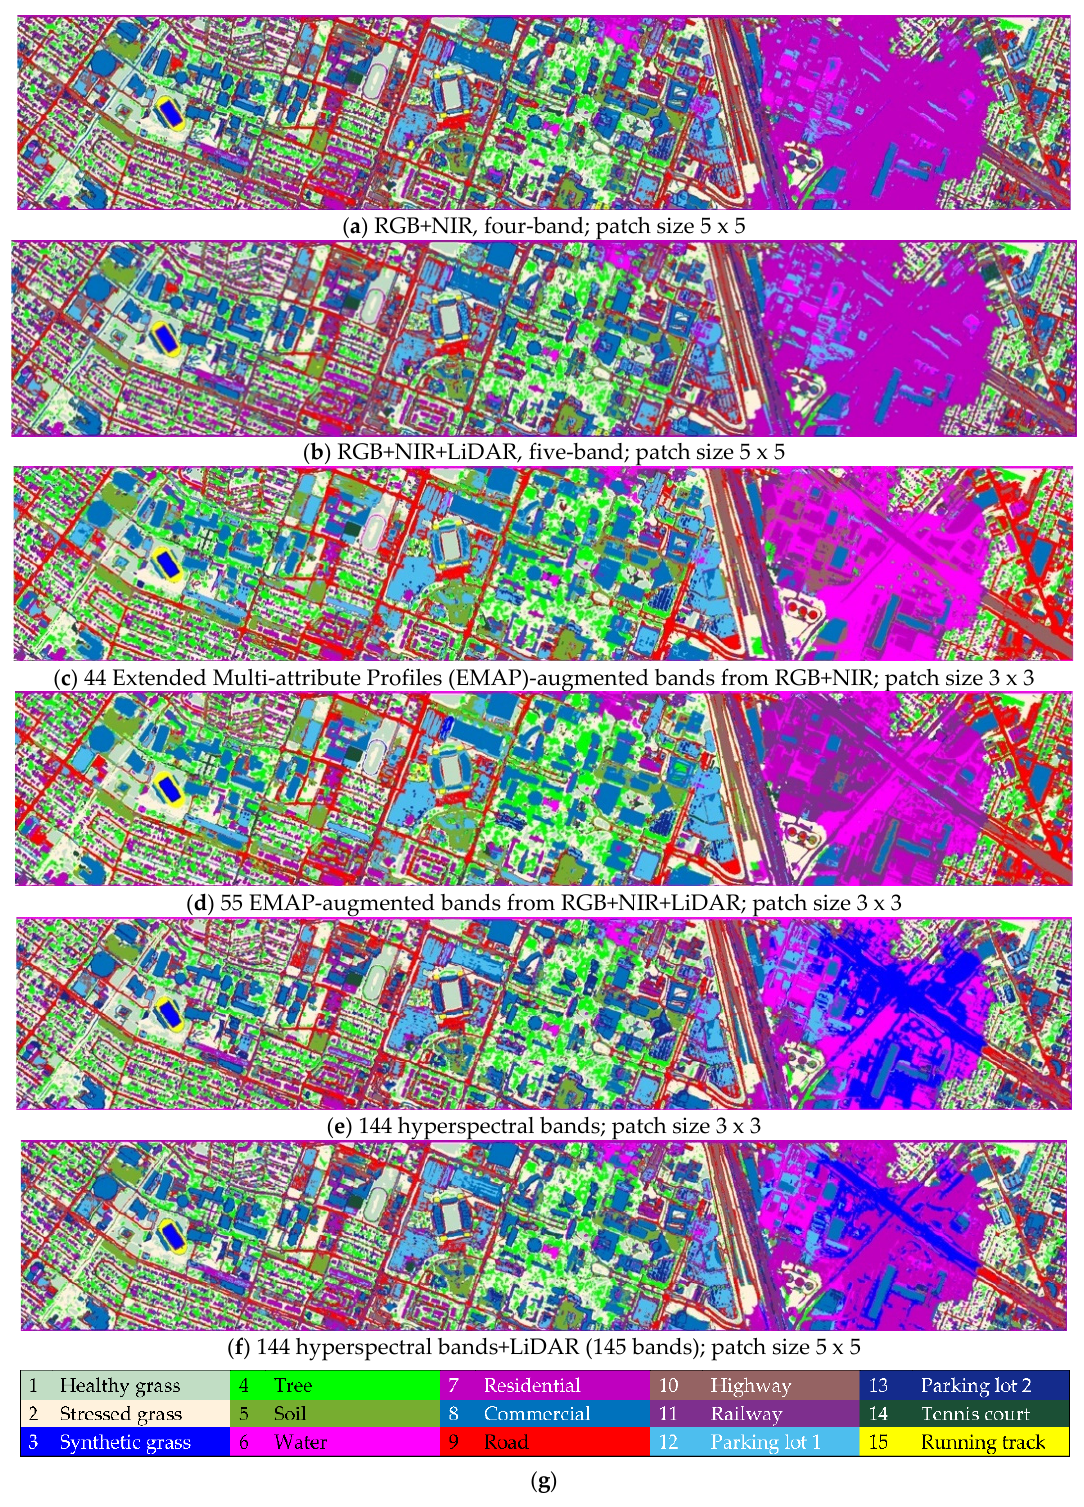
Figure 6. Estimated land cover maps by our customized CNN method for the whole image.